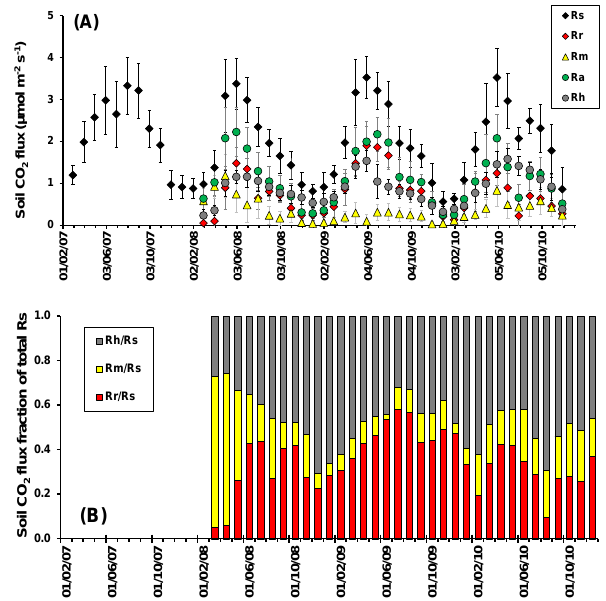
Fig. 4. (A) Monthly mean CO 2 efflux from soil respiration ( R s ) , and contributions from roots ( R r ) , mycorrhizal hyphae ( R m ) , au- totrophic ( R a = R r + R m ) and heterotrophic soil fluxes ( R h ) at the Straits Enclosure, Alice Holt forest from 2007 to 2010. Separated flux components only available from March 2008. Averages ± s.d.